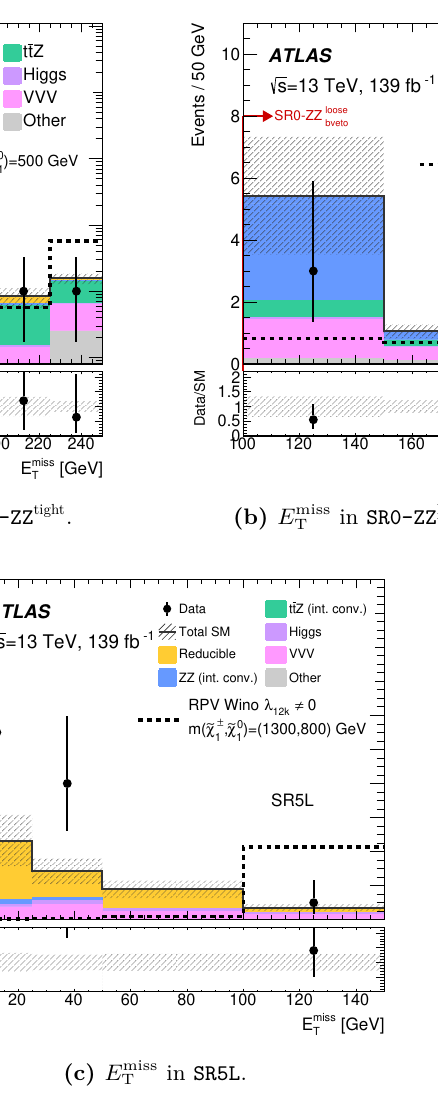
distribution in (a) SR0-ZZ loose and SR0-ZZ tight , (b) SR0-ZZ loose Figure 8. The E miss T and (c) SR5L for events passing the signal region requirements except the E miss tributions for data, the estimated SM backgrounds after the background-only fit, and an example SUSY scenario are shown. “Other” is the sum of the tWZ , t ¯ tWW , t ¯ tZZ , t ¯ tWZ , t ¯ tWH , t ¯ tHH , t ¯ ttW , and t ¯ tt ¯ t backgrounds. The last bin captures the overflow events. The lower panel shows the ratio of the observed data to the expected SM background yield in each bin. Both the statistical and systematic uncertainties in the SM background are included in the shaded band. The red arrows indicate the E miss selections in the signal T